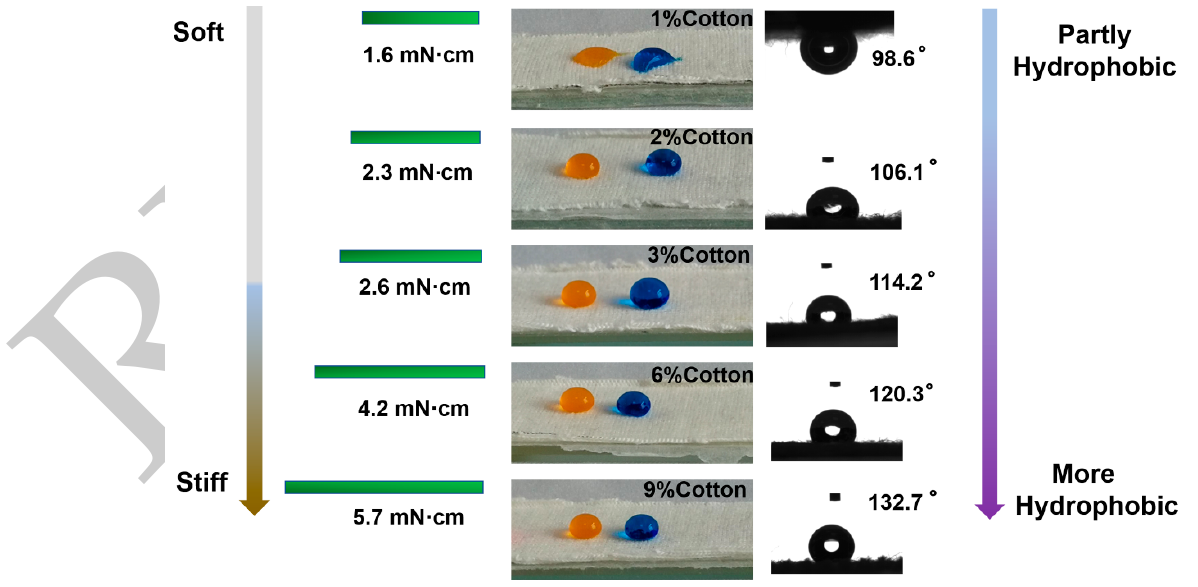
Figure 2. The water contact angle and bending rigidity of cotton fabric modified with cationic antibacterial agent.